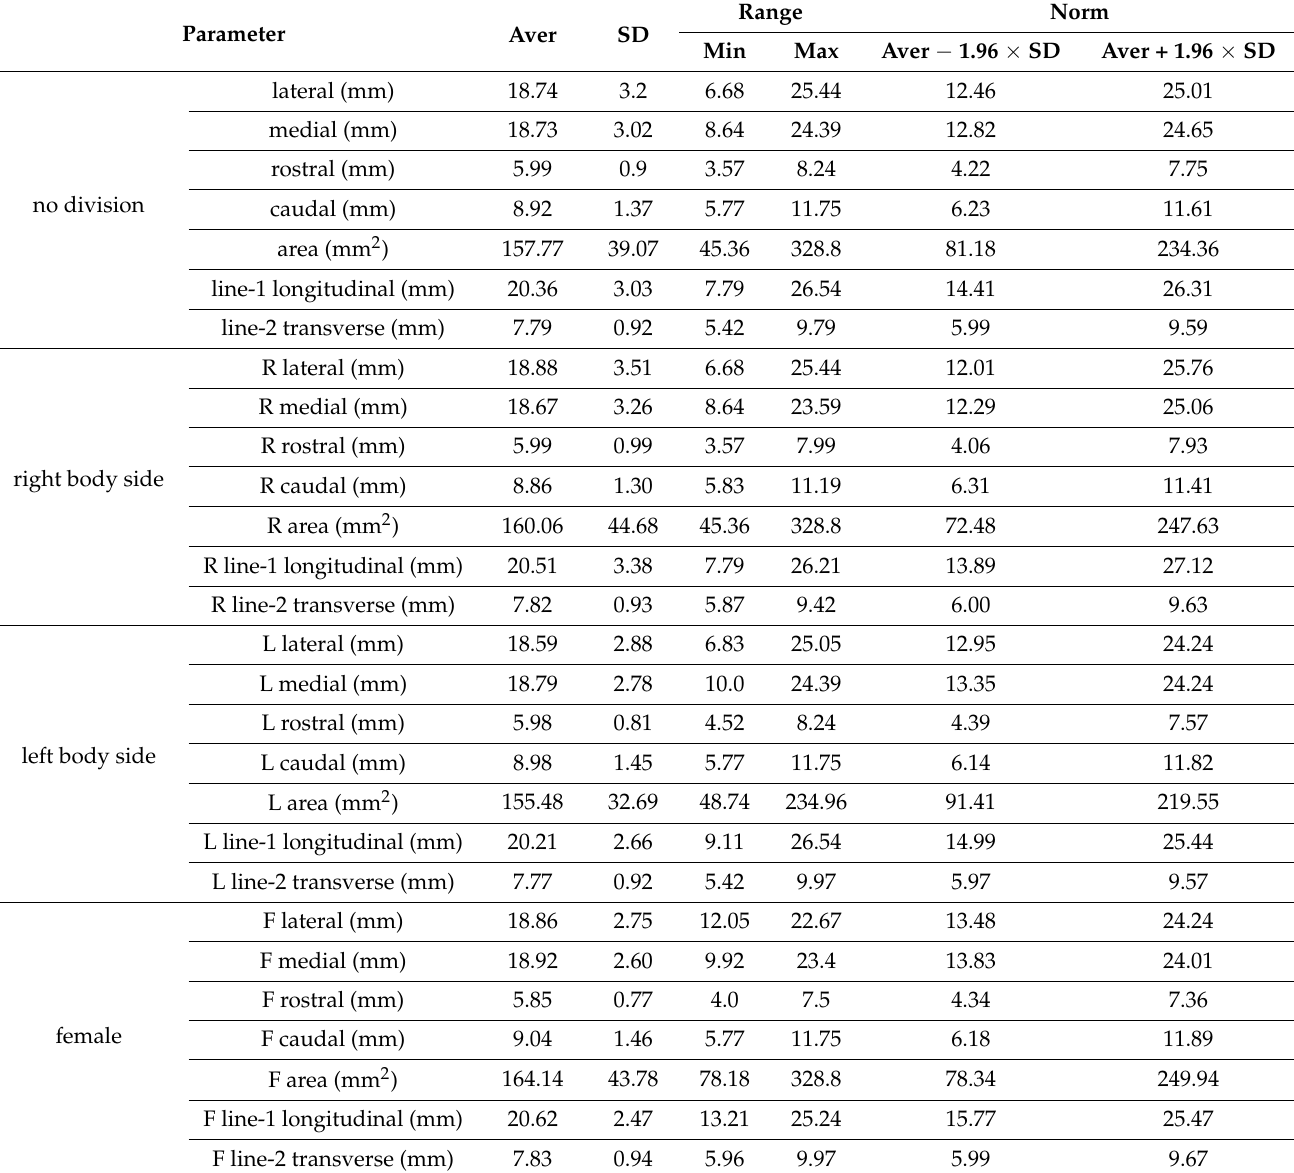
Table 1. Summary of anatomical measurement results for the whole examined